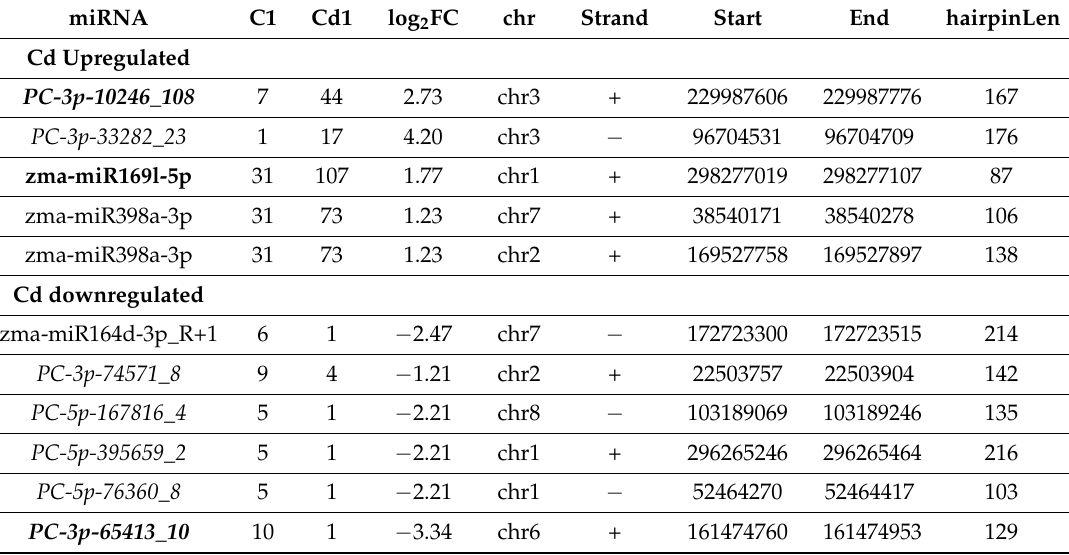
Table 2. Cadmium (Cd)-responsive 10 miRNAs in maize xylem